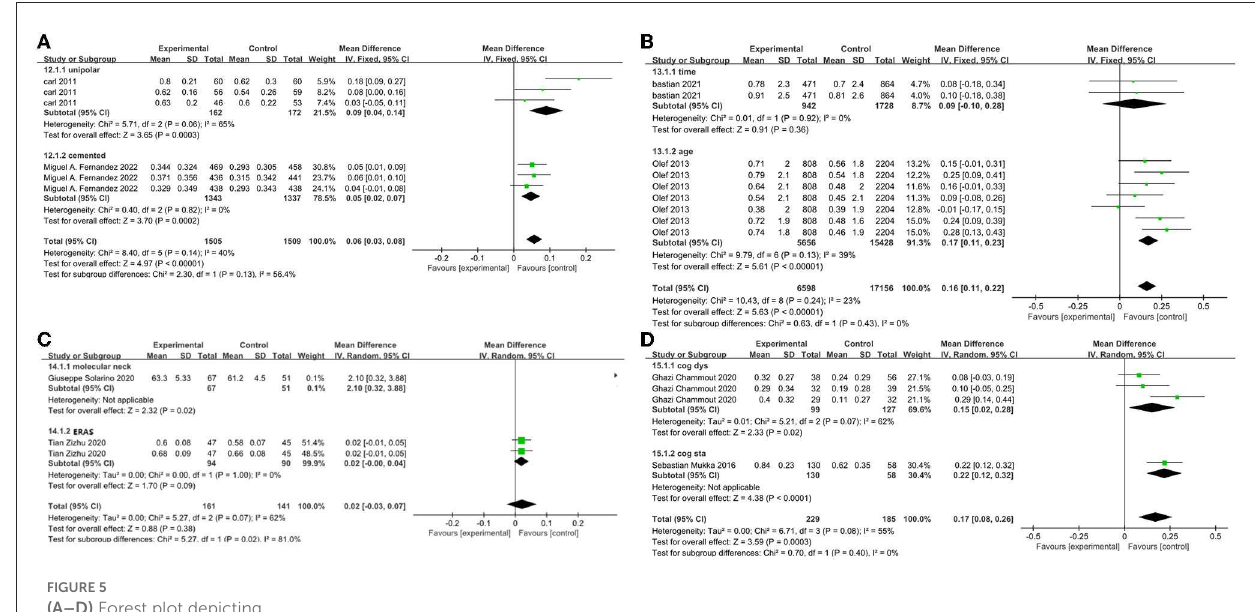
FIGURE5 (A–D) Forest plot